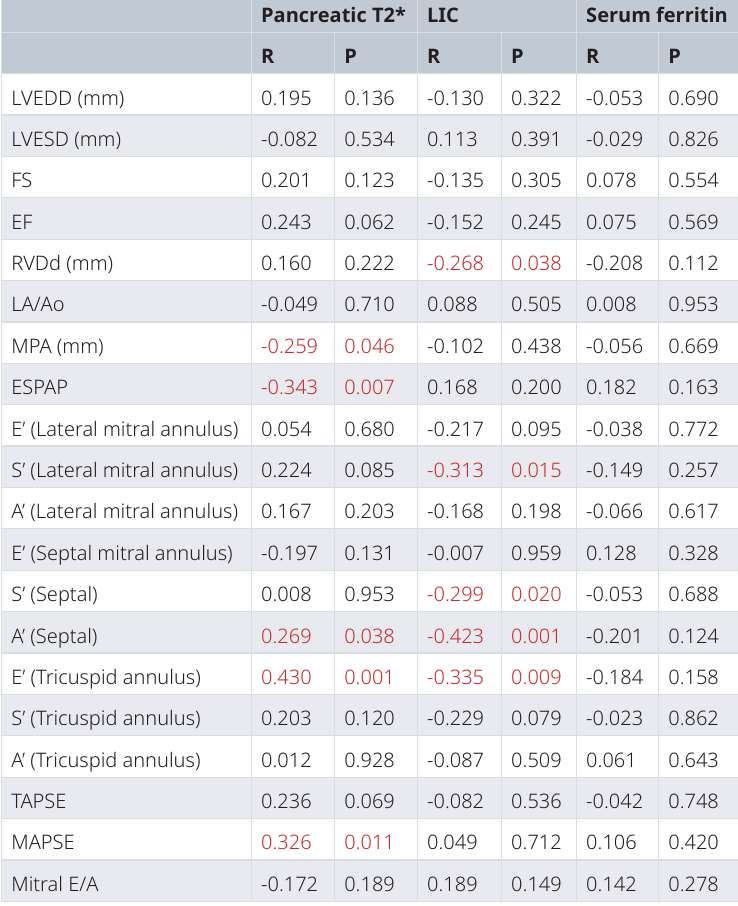
Table 4. Correlations of pancreatic T2*, liver iron concentration and ferritin with echocardiographic and tissue doppler